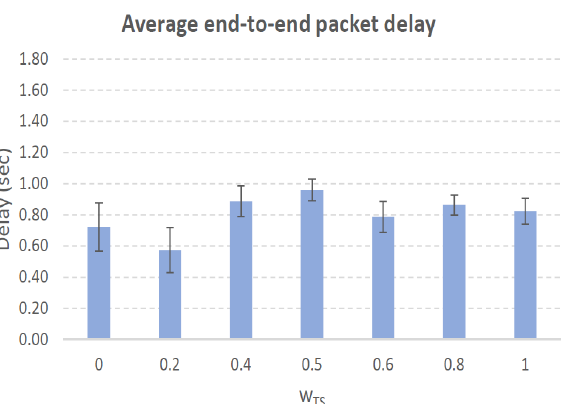
Figure 17. Average end-to-end packet delay. Scenario with very high social media interaction (TS normal distribution with µ = 4 and σ = 1). Nodes’ density = 100 nodes/km 2 .